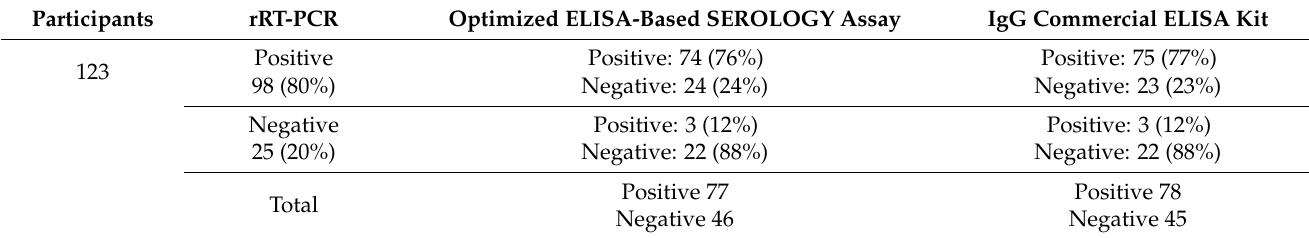
Table 3. Assay performance determination of the optimized ELISA-based serology and the commer- cial ELISA kit in 123 venous serum human